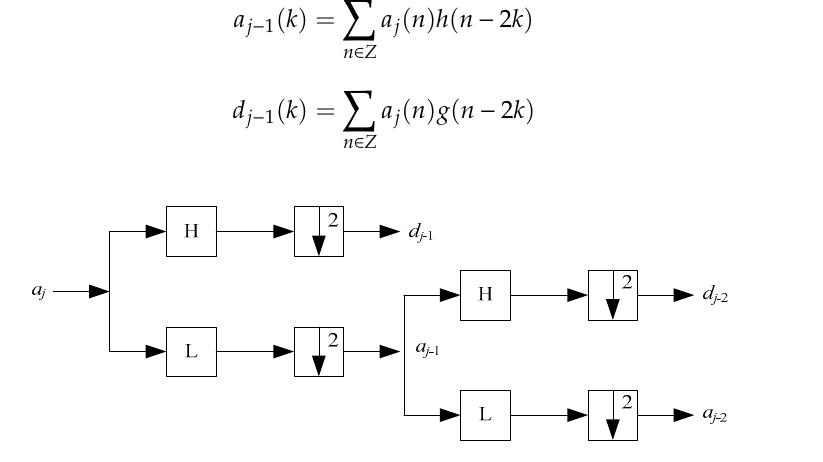
Figure 1. Multiscale wavelet decomposition.